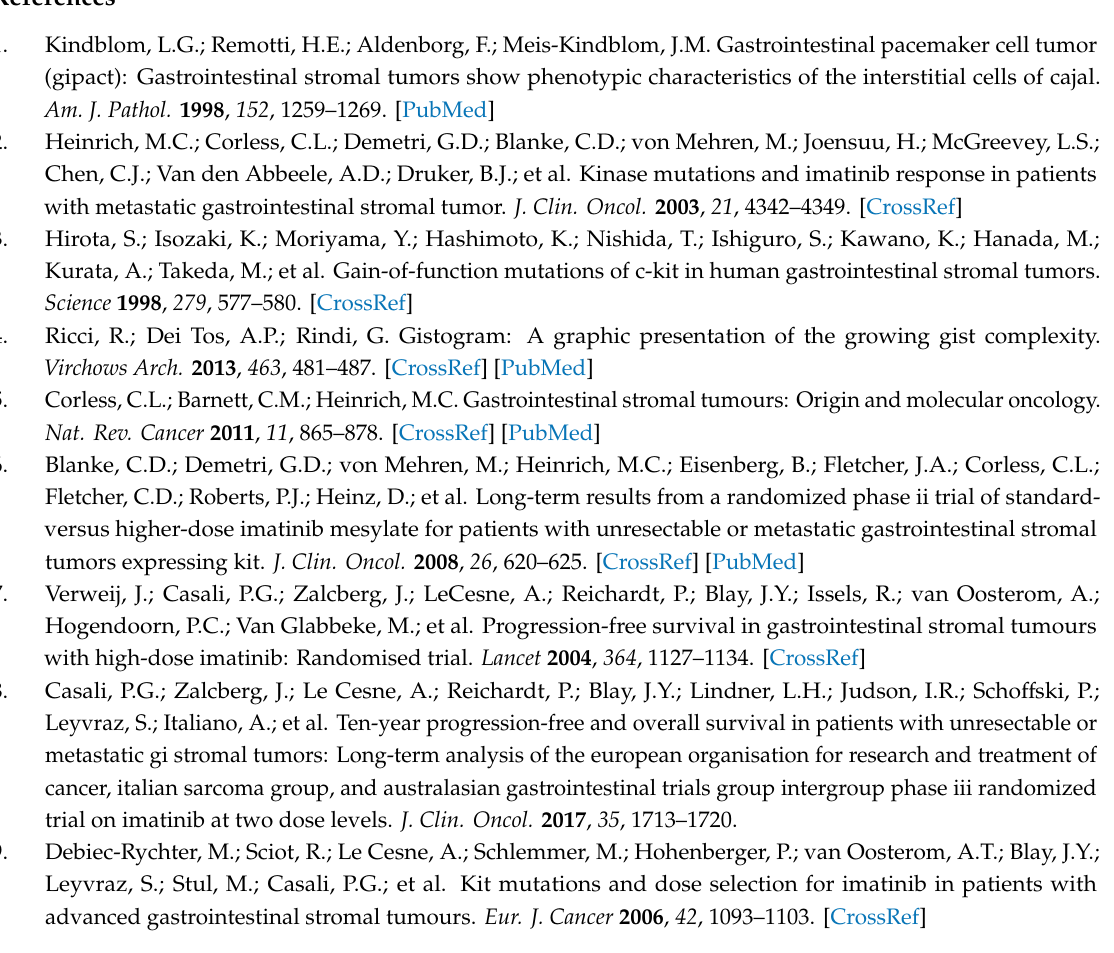
stromal tumors; Table S2: Di ff erentially expressed microRNAs between imatinib-resistant gastrointestinal stromal tumors with and without secondary KIT mutations; Table S3: List of 352 di ff erentially expressed genes between imatinib-resistant and imatinib-naïve GIST samples; Table S4: Di ff erentially expressed genes associated with the top deregulated canonical pathways; Table S5: Ingenuity Pathway Analysis Symbols; Table S6: Di ff erentially expressed microRNAs between imatinib-naïve and imatinib-resistant gastrointestinal stromal tumors in the samples that were used for mRNA profiling; Table S7: Overview of the microRNA expression levels measured in the imatinib-naïve and imatinib-resistant gastrointestinal stromal tumor samples; Figure S1: Di ff erentially expressed mRNAs between imatinib-naïve and imatinib-resistant GIST samples; Figure S2: Top deregulated canonical pathways between imatinib-naïve and imatinib-resistant gastrointestinal stromal tumors; Figure S3: Quantitative RT-PCR validation of di ff erentially expressed microRNAs and mRNAs in imatinib-naïve and imatinib-resistant gastrointestinal stromal